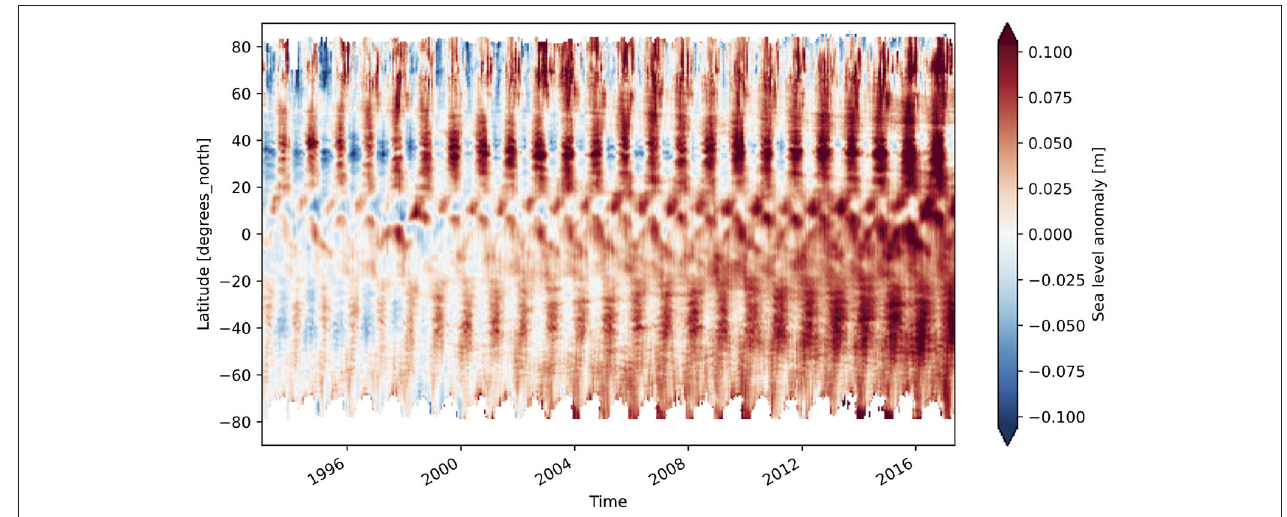
FIGURE 5 | Daily zonal mean sea-level anomaly, calculated from Pangeo Forge ARCO